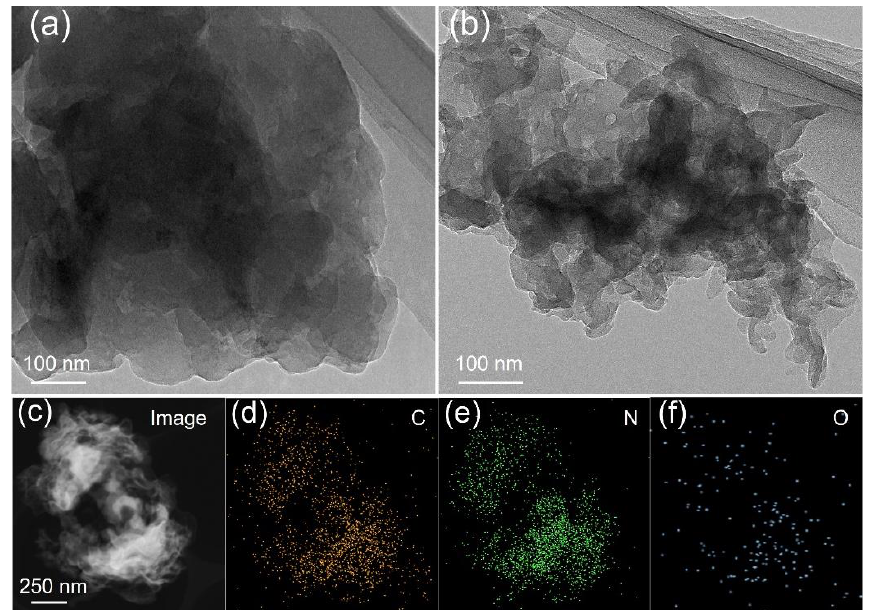
Figure 2. TEM images of the synthesized CN ( a ) and CN-S24 ( b ) samples; EDS mapping of CN-S24 ( c – f ).